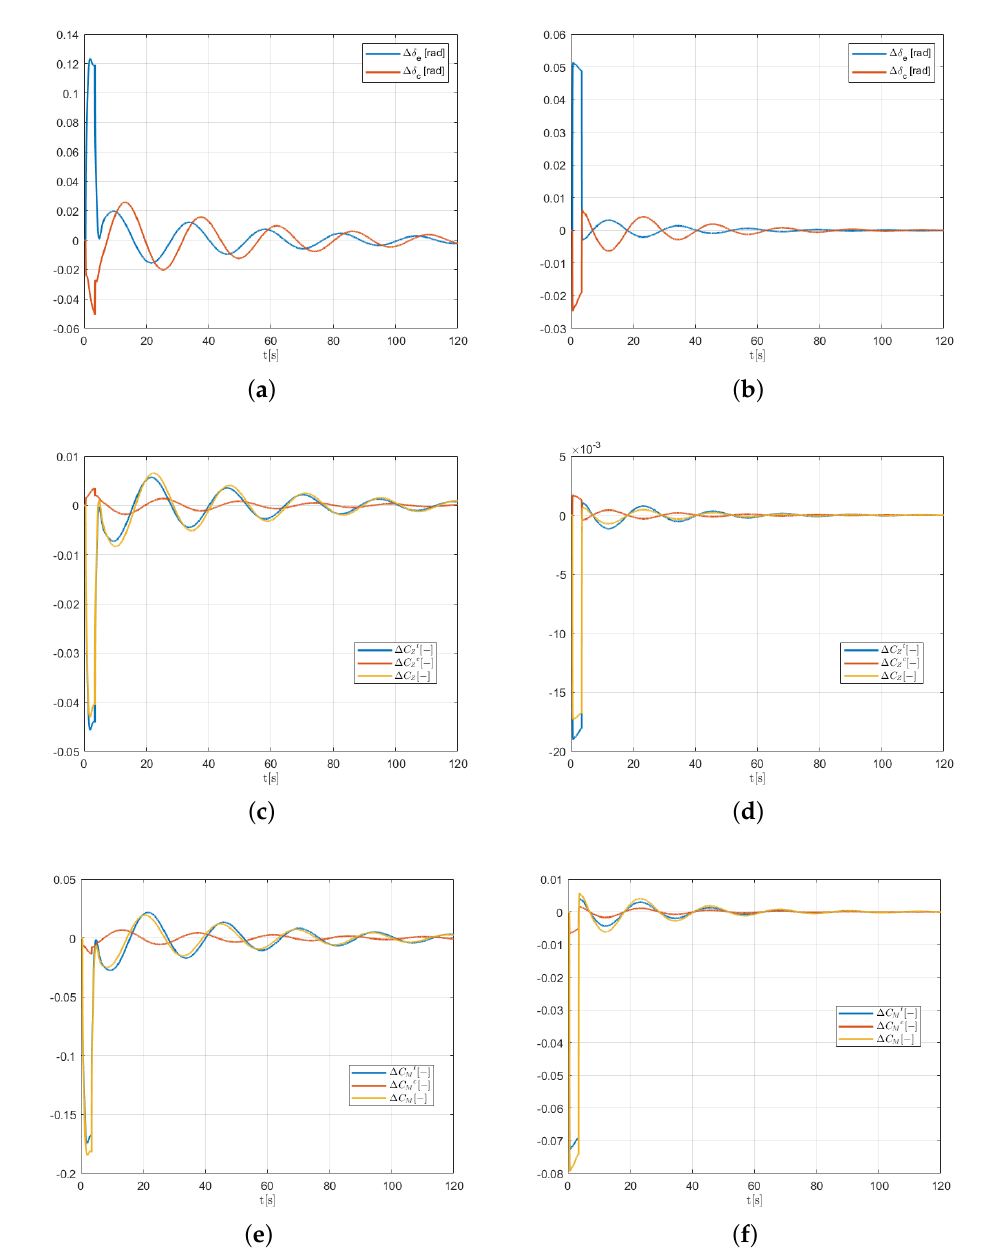
Figure 12. Comparison of the time histories of controls (first row, a , b ), vertical control force coefficient (mid row, c , d ) and control pitching moment (bottom row, e , f ), for a control set-point history as in Figure 11, for the three-surface testbed conditioned by a Scheme B, pole placement designed controller (left) and an LQR controller